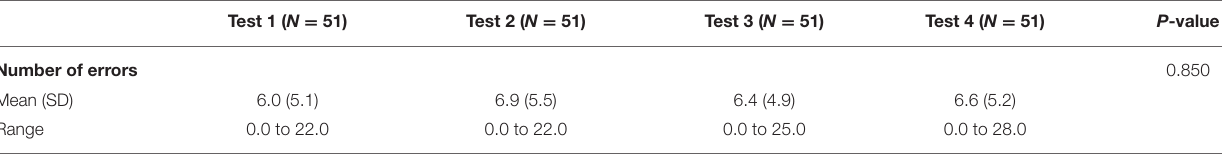
TABLE 9 | Distribution of the number of errors per participant vs. test